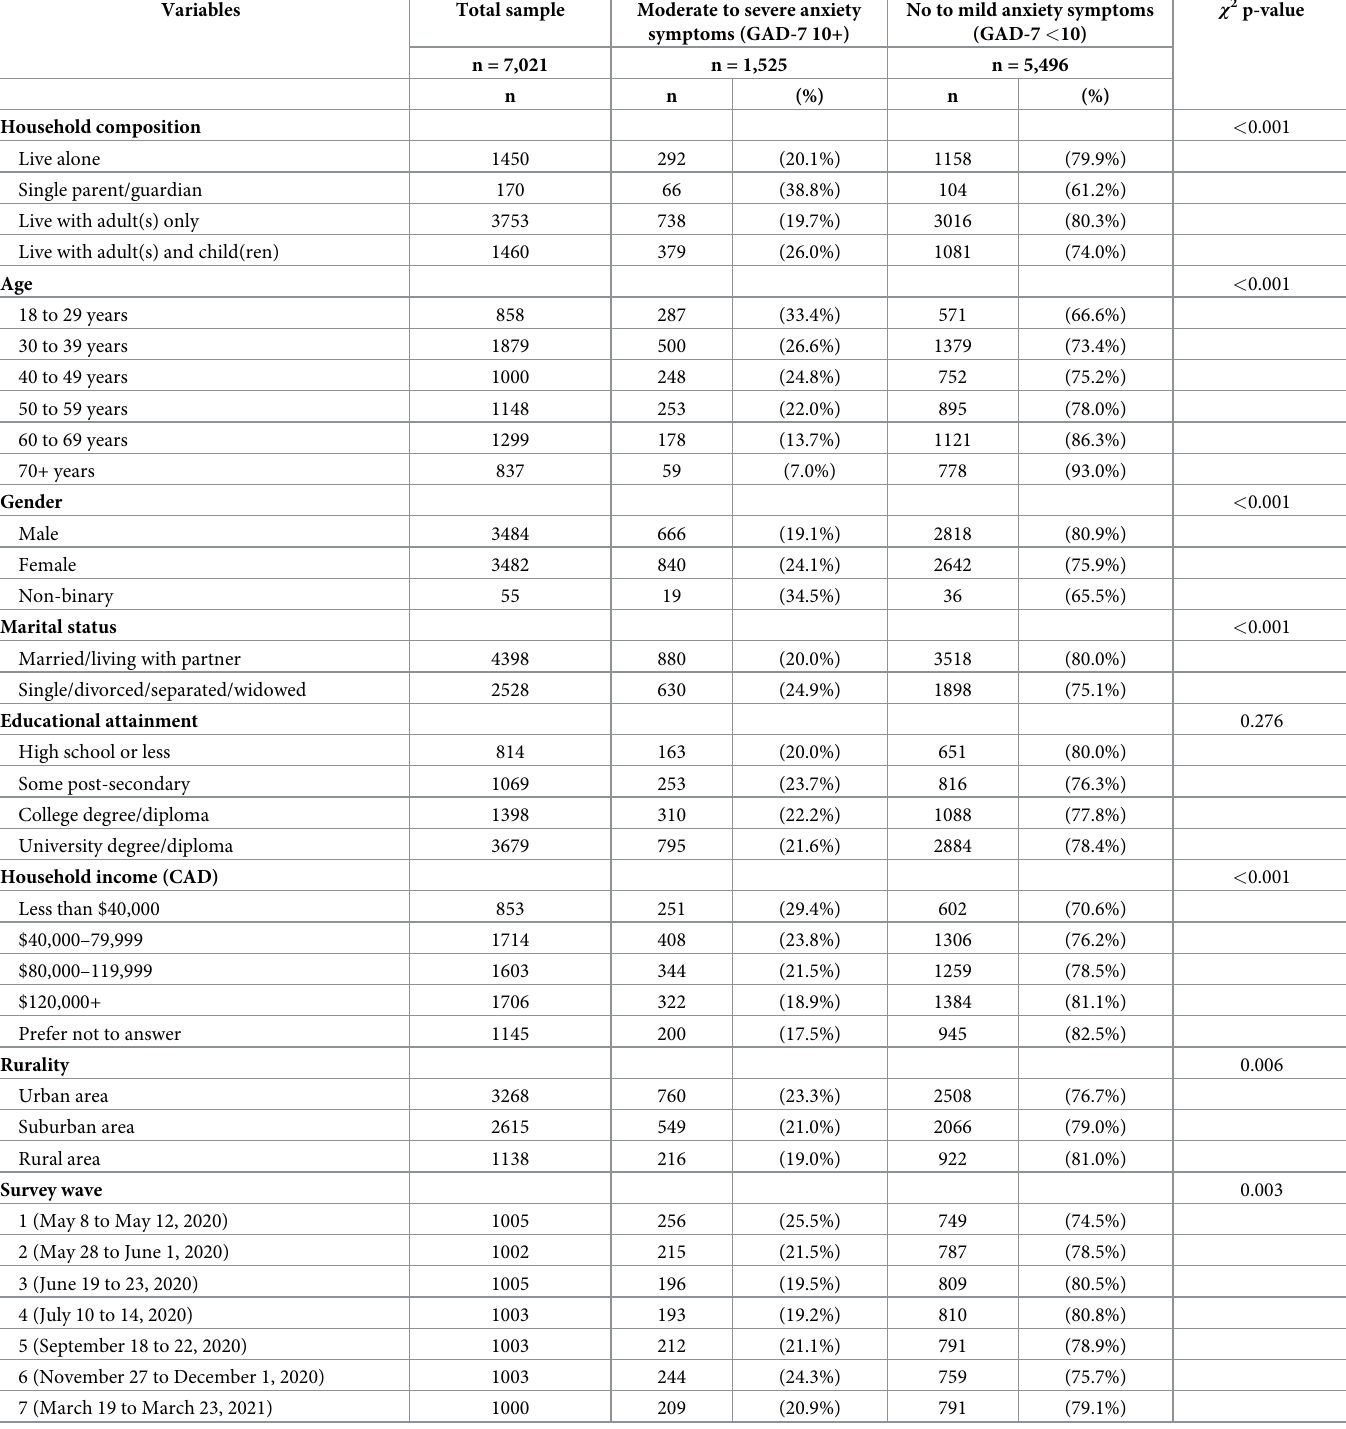
Table 1. Sample characteristics by anxiety symptoms, Canadian adults aged 18+ years during the COVID-19